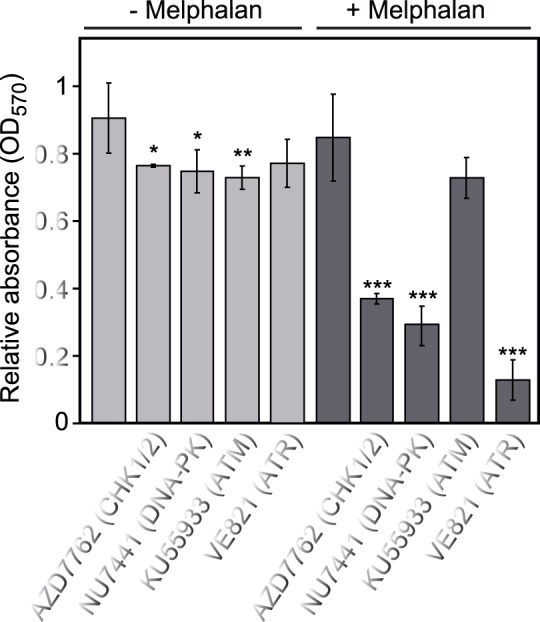
Effect of PI3-kinase-like kinase (PIKK)- and CHK1/2 inhibitors on the proliferation of 8226-LR5 cells.The MTT assay was used to monitor the survival after 72h incubation with the various inhibitors ±2.5 Melphalan. CHK1/2 inhibitor AZD7762 (0.1 µM), DNA-PK inhibitor NU7441 (0.2 µM), ATM inhibitor KU55933 (3 µM), ATR inhibitor VE821 (1 µM). Whereas a moderate inhibition on proliferation was observed with either inhibitor alone, strong inhibition was observed in combination with melphalan for the CHK1/2, DNA-PK and ATR inhibitors. Each bar represents the mean of at least 5 independent experiments with standard deviations as indicated. P-values were calculated using 2-sample t-test with equal variance. >95%, >99% and >99.9% confidence levels indicated by *, **, and ***, respectively.